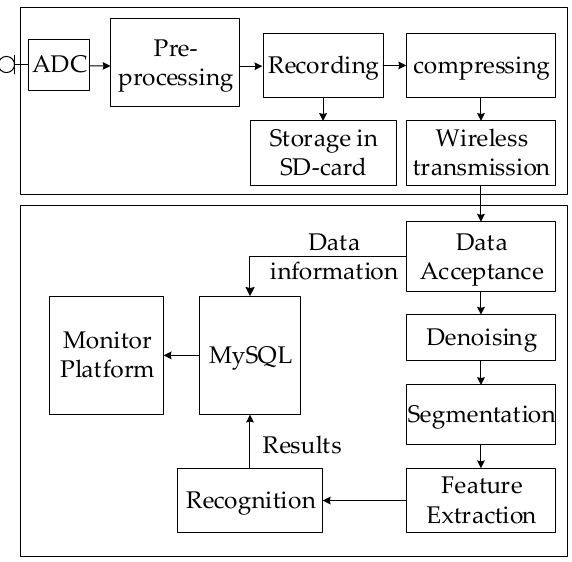
Figure 2. The block diagram of the proposed system.